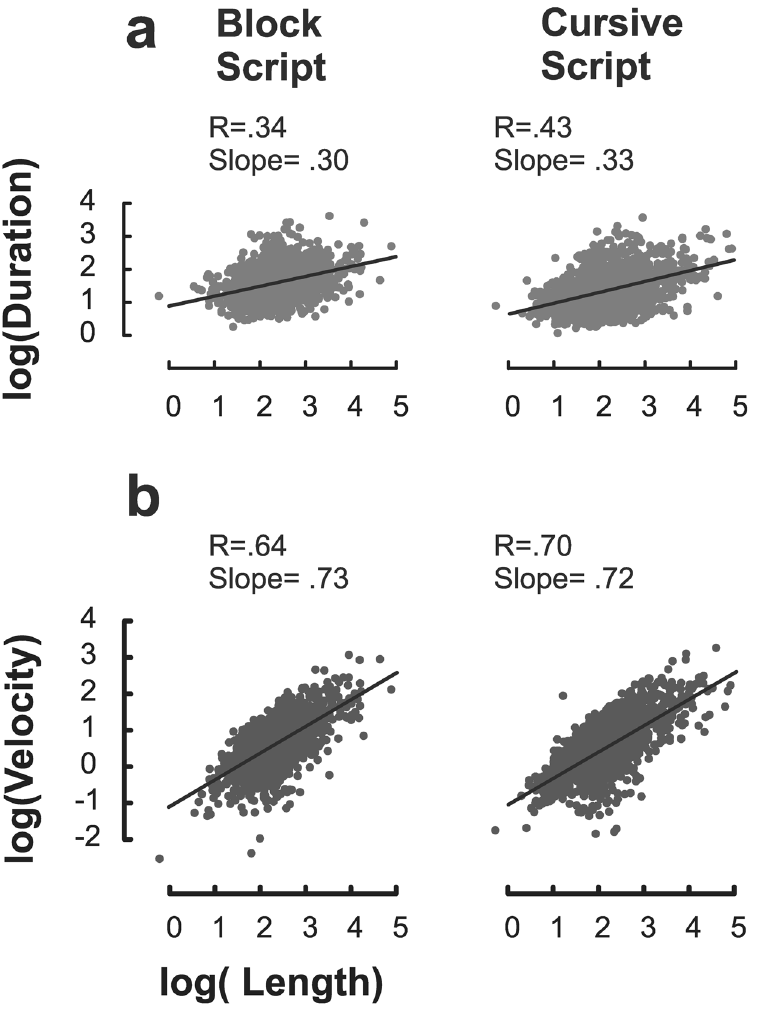
Figure 2. Isochrony. Panel a reports the log-log plot (natural logarithm) of the word duration (sec) as a function of its length(cm). Panel b reports the log-log plot (natural logarithm) of the mean velocity (cm/sec) as a function of its length. Subpanels on the left represent all-capital block script data, subpanels on the right depict cursive data. All log-log plots were computed on the entire dataset, thus including the five groups of participants all together and the conditions Spontaneous , Big , and Fast